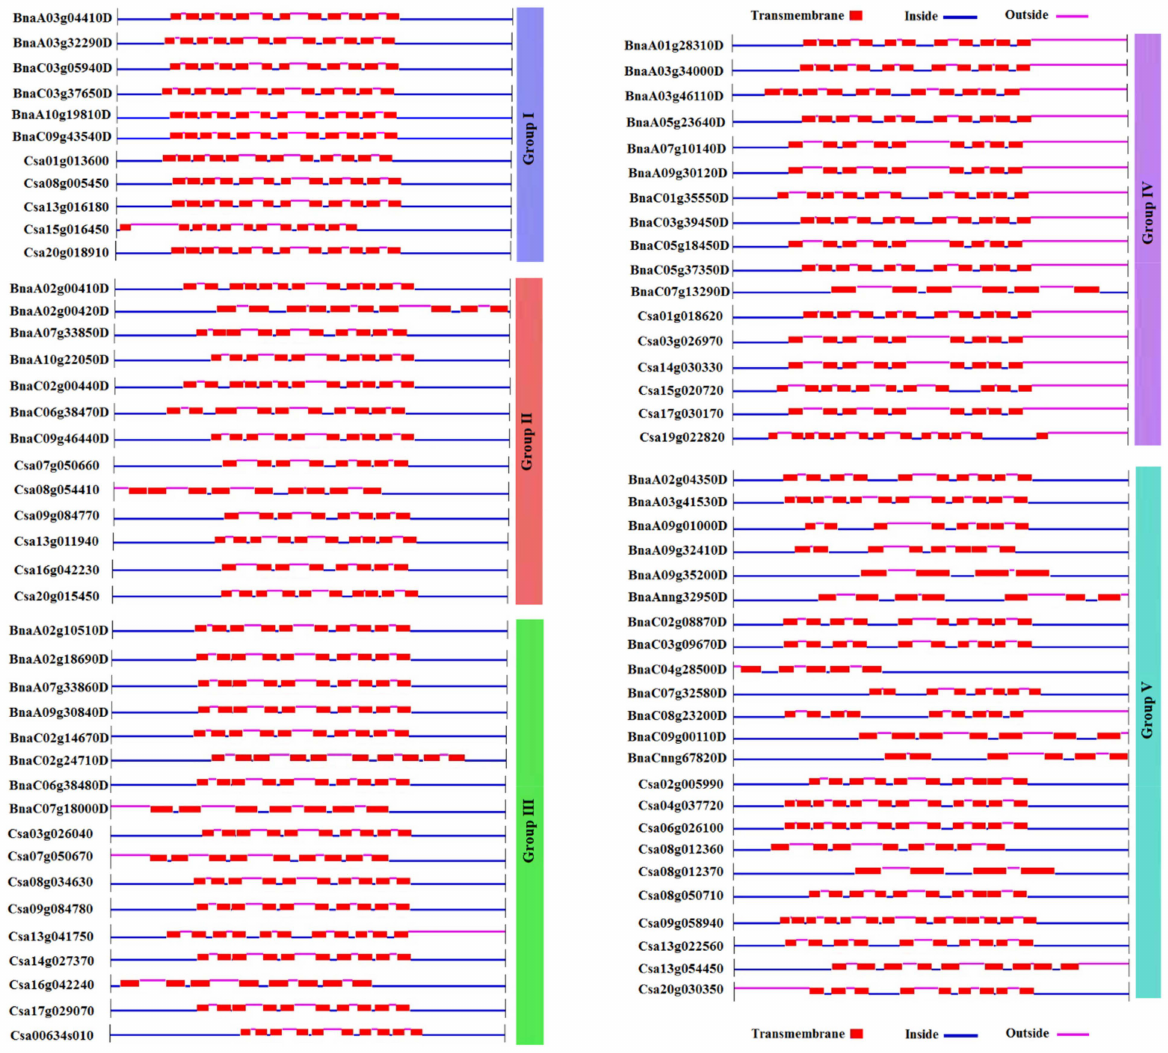
Figure 5. The transmembrane structures of the SULTRs in C. sativa and B. napus . The grouping was based on the phylogenetic